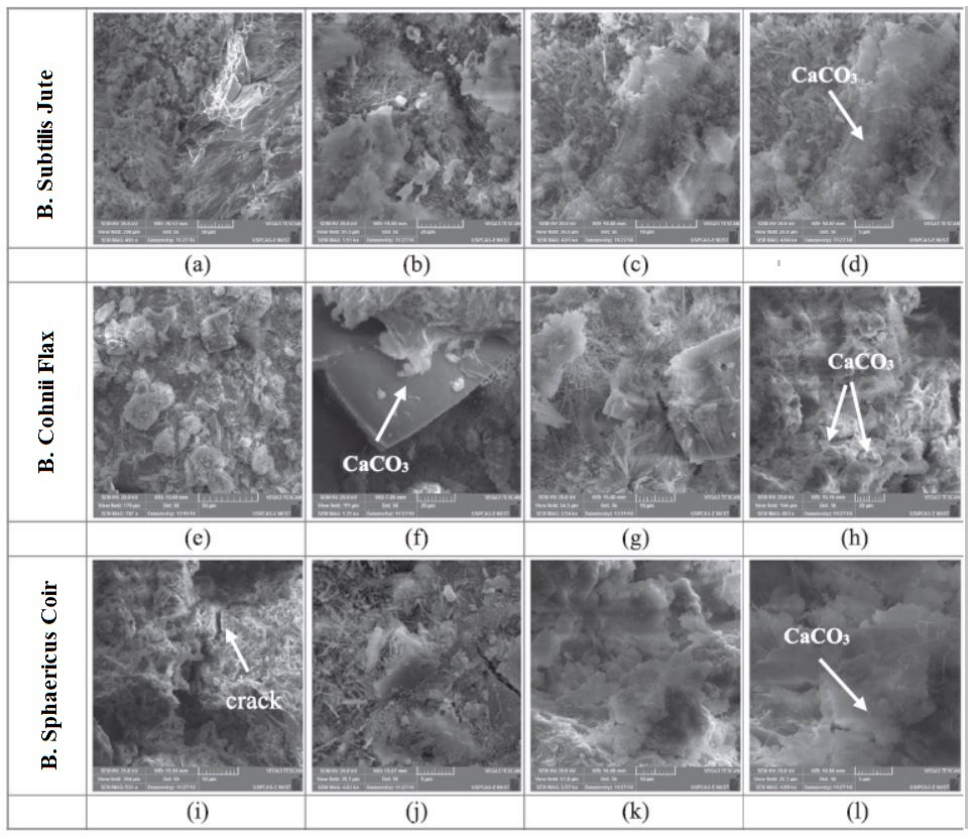
Figure 9. ( a – l ) The SEM image of the healed specimens prepared with different types of fibers [114] .